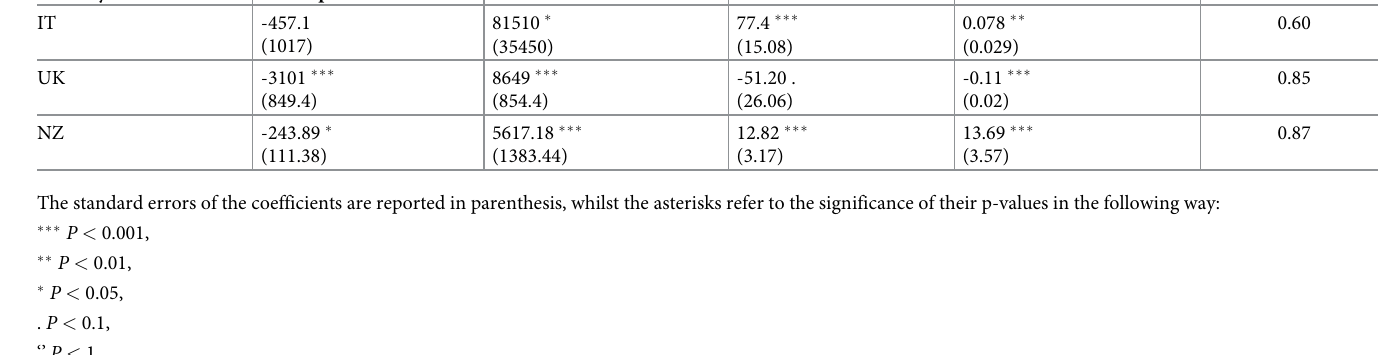
Table 4. Results for regression over the weeks with respect to the average number of posts in a country with multiple controls: ONCI, Stringency Index (SI) and the number of COVID-19 confirmed cases.